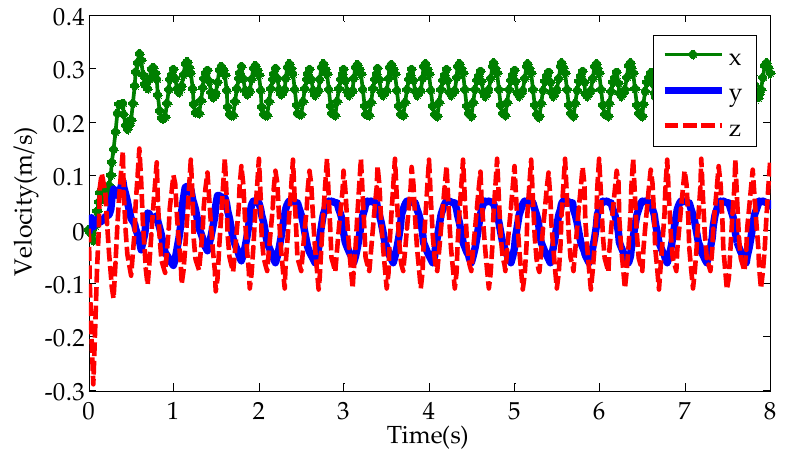
Figure 9. Velocity curves for the centroid of the robot trunk.